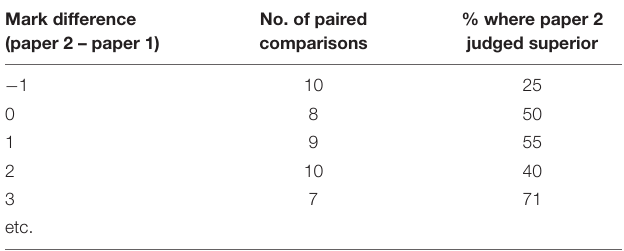
TABLE 1 | Relationship between mark difference and probability of